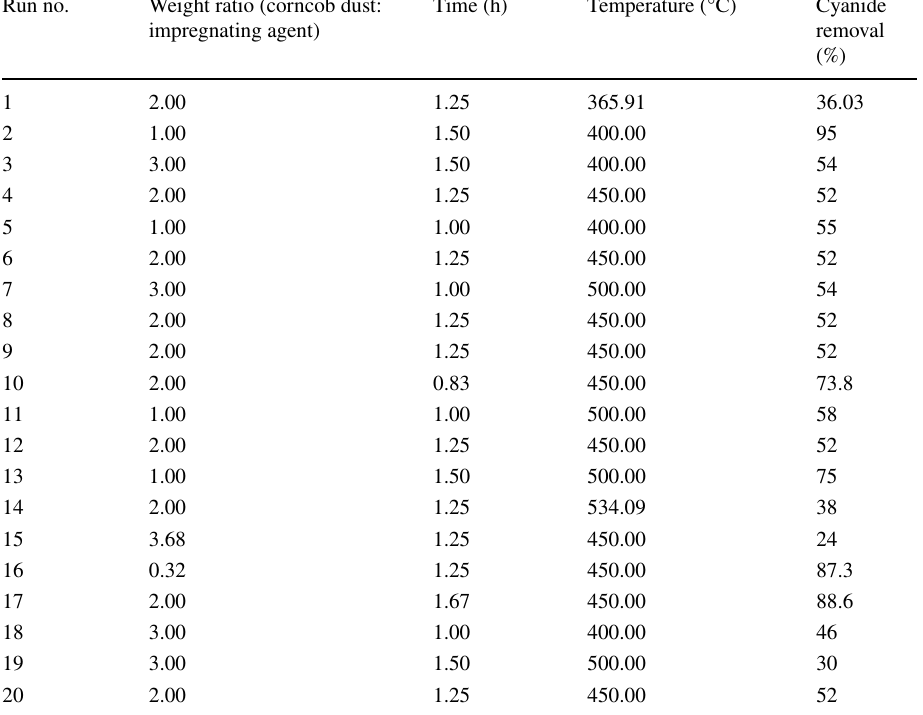
Run no. Weight ratio (corncob dust: impregnating agent)